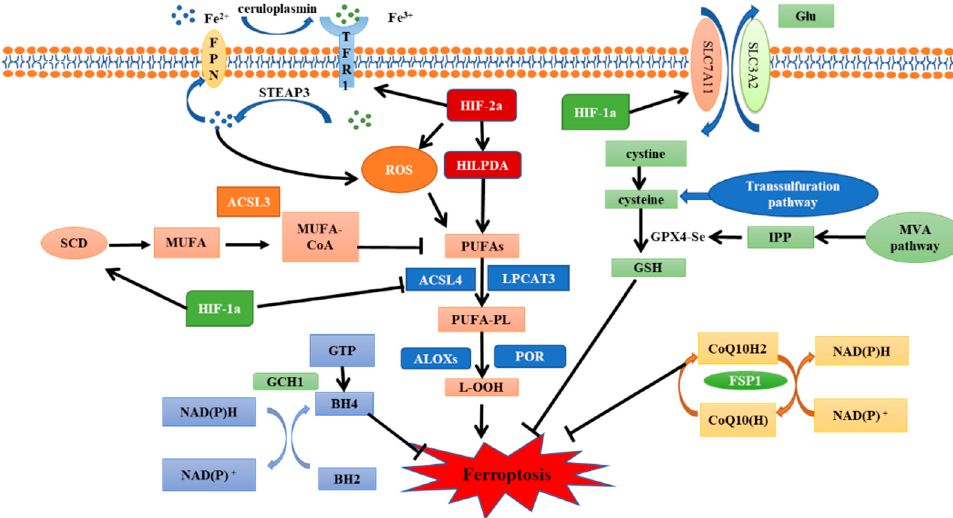
Figure 2. The regulatory pathways of ferroptosis and the role of HIF.